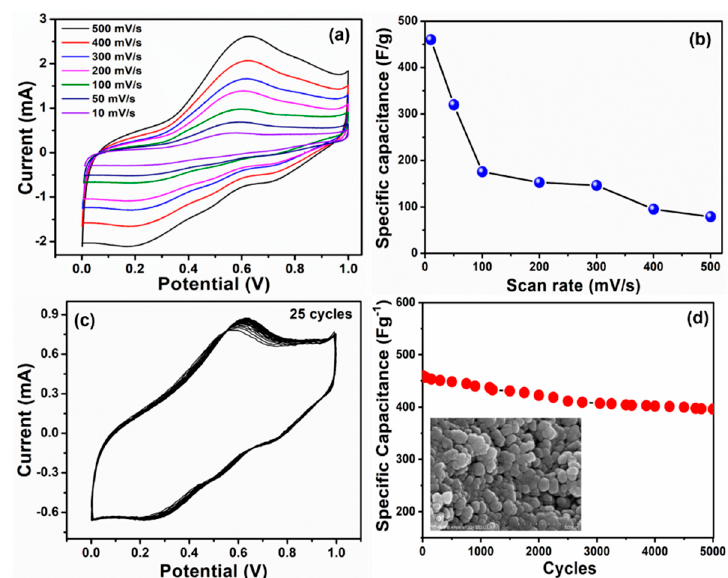
Figure 7. The ( a ) CV curves and ( b ) specific capacitance of the synthesized mesoporous Mn 2 O 3 electrode at different scan rates ranging from 10 to 500 mV·s − 1 , ( c ) multicycles CV curves and ( d ) variation in the specific capacitance of the synthesized mesoporous Mn 2 O 3 electrode after 5000 cycles. The inset shows the FESEM image of the synthesized mesoporous Mn 2 O 3 electrode after 5000 cycles.